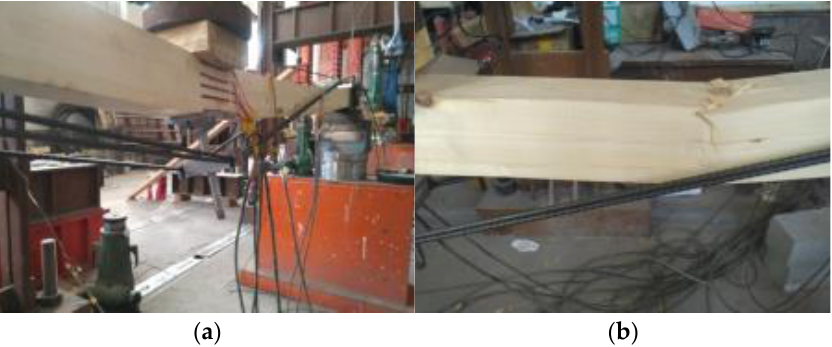
Figure 14. Failure mode of L B1 . ( a ) Overall instability of left span; ( b ) Compressive failure of right span.